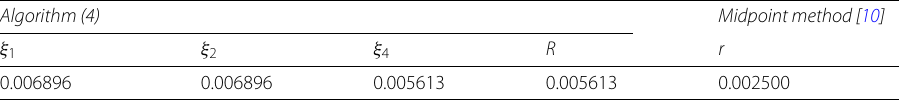
Table 4 Parameters for example 4 Algorithm(4)